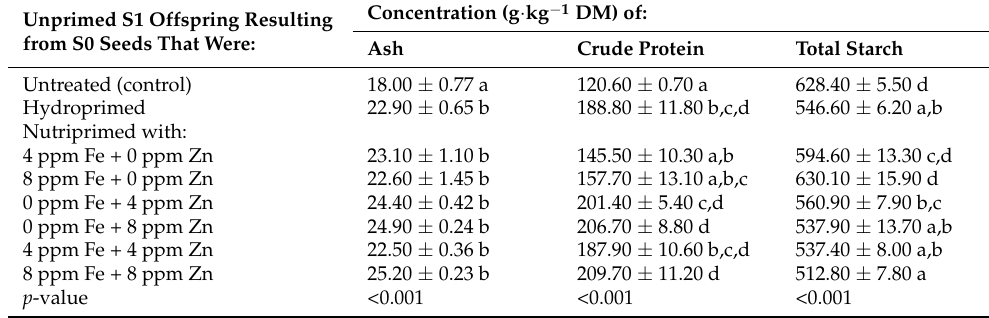
Table 3. Mean ( ± S.E.) concentration of ash, crude protein, and total starch (g · kg − 1 dry matter, DM) determined per unprimed S1 offspring resulting from S0 seeds that were untreated (control), hydroprimed or nutriprimed with Fe and/or Zn. The mean values resulted from nine replicates. Values followed by different lowercase letters represent statistically significant differences ( p <